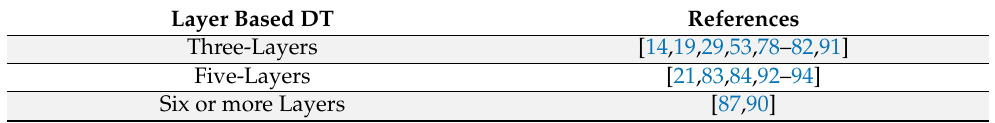
Table 3. Different approaches within LBA using three are more